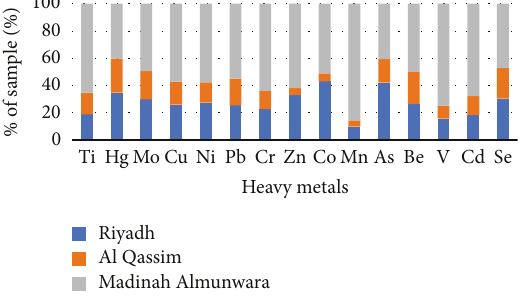
Figure 4: The percentage of PI in each metal in the study